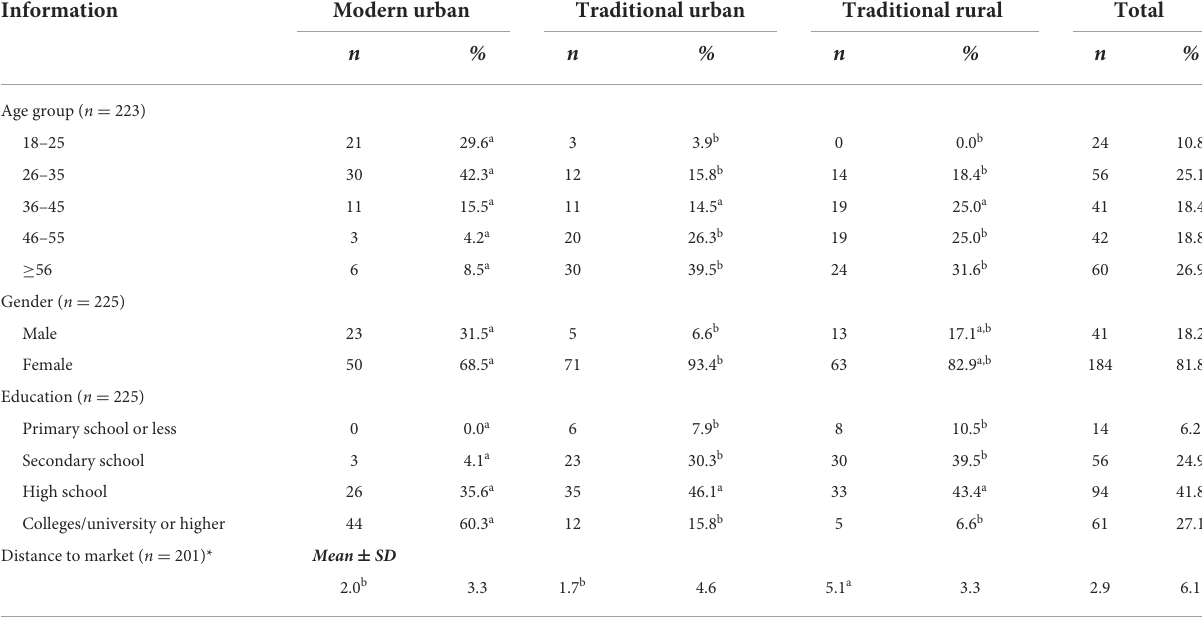
TABLE 1 General information on 225 pork consumers interviewed at three retail types in Northern Vietnam in 2019.